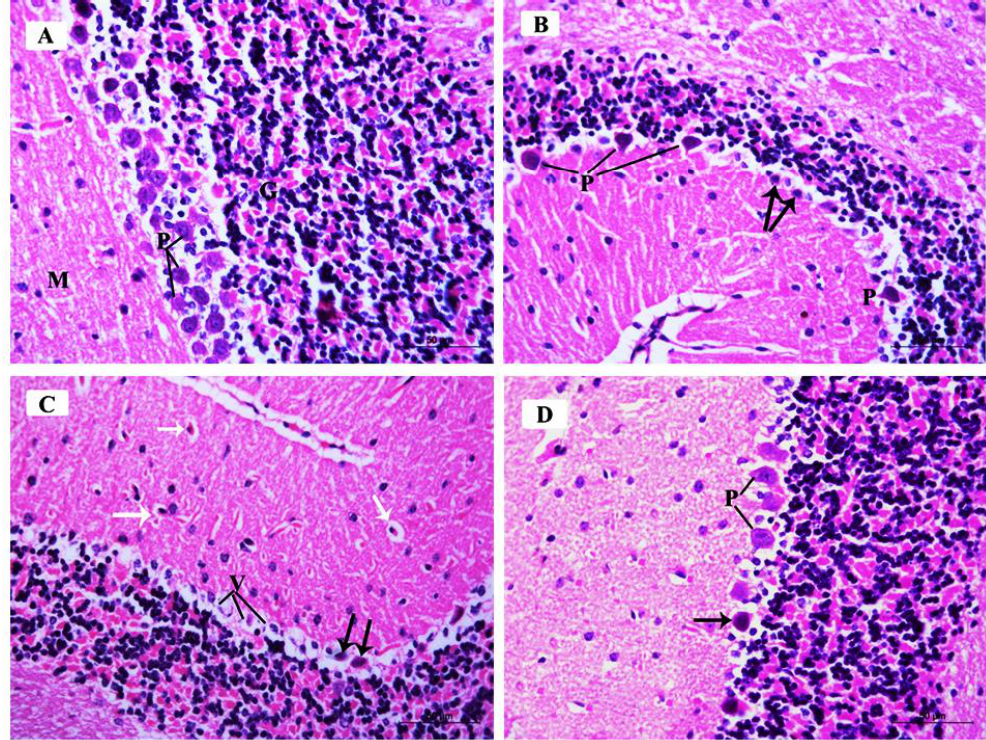
Figure 9. Photomicrographs of H&E-stained sections of the mouse cerebellar cortex of the different study groups; ( A ): Control group and ceftriaxone group display the molecular cell layer (M) containing small scattered basket cells and stellate cells. Purkinje cell layer (P) contains large pyriform-shaped cells having vesicular open face nuclei and eosinophilic cytoplasm with prominent Nissl’s granules. The granular cell layer (G) contains crowded small deeply stained cells. ( B ): ARS group displays few Purkinje cells (P) with deeply stained nuclei, eosinophilic cytoplasm, and is surrounded by vacuolated neuropil. Other Purkinje cells are shrunken with pyknotic nuclei and vacuolated cytoplasm (arrows). ( C ): ARS group shows Purkinje cells having vacuolated cytoplasm (V) and pyknotic nuclei (black arrows). Basket cells and stellate cells are surrounded with perineuronal spaces (white arrows). ( D ) ARS + ceftriaxone group, Purkinje cells are increased in number; most of them displays open face nuclei (P) while few of them have darkly stained nuclei and eosinophilic cytoplasm (arrow). (Hx. &E. × 400).